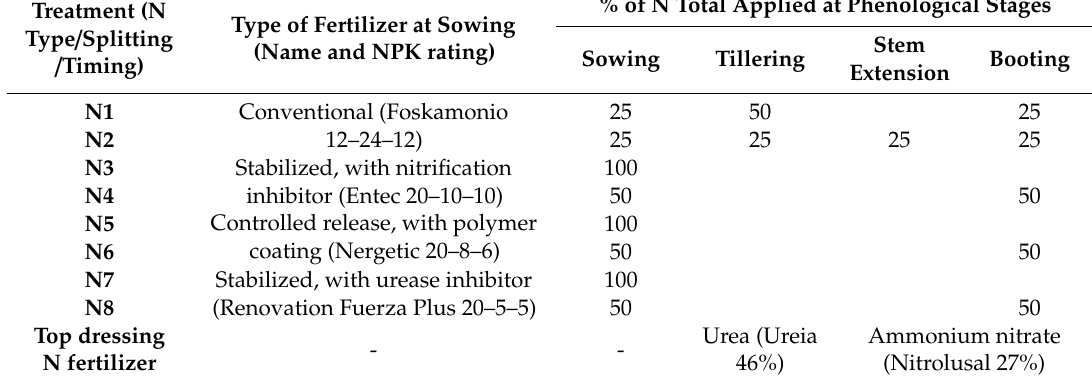
Table 6. Nitrogen fertilizer type and name, splitting (% of N total), and timing (phenological stage) treatments through the wheat